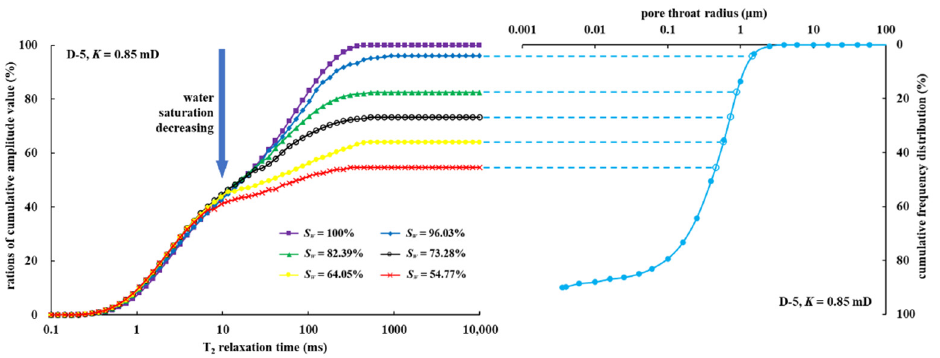
Figure 5. T 2 accumulative curve under different water saturation and accumulative distribution curve of core plug D-5.